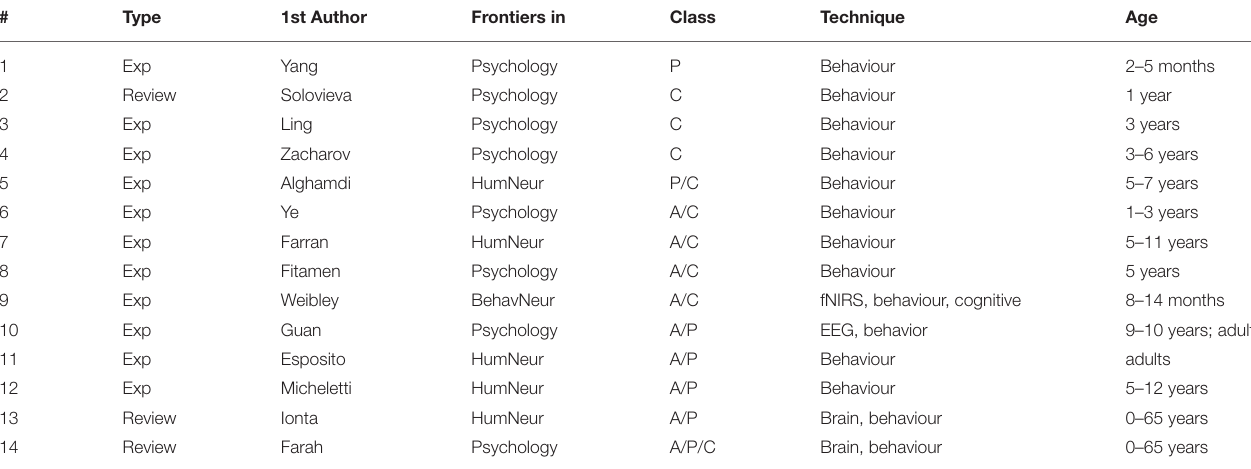
TABLE 1 | Classification of included articles as a function of the RT’s topics (P, Perception; C, Cognition; A,